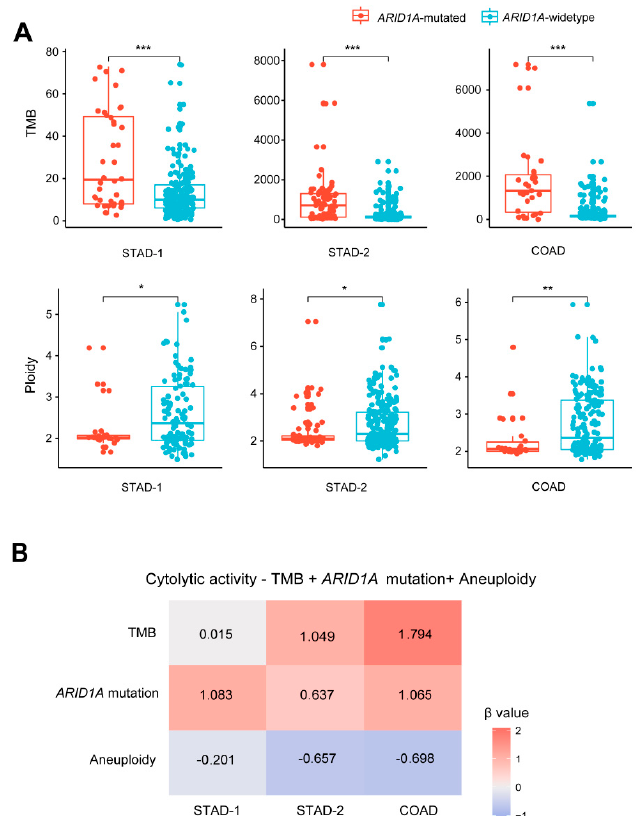
Figure 2. Associations among ARID1A mutations, tumor mutation burden (TMB), tumor aneuploidy levels, and immune activity in GI cancers. ( A ) ARID1A -mutated GI cancers have significantly higher TMB and lower aneuploidy levels than ARID1A -wildtype GI cancers (Mann-Whitney U test, P < 0.05). * P < 0.05, ** P < 0.01, *** P < 0.001. ( B ) Logistic regression analysis shows that ARID1A mutation and TMB are positive predictors and the aneuploidy level is a negative predictor for immune cytolytic activity. TMB is defined as the total number of somatic mutations in tumor and tumor aneuploidy level is defined as the tumor ploidy score assessed by ABSOLUTE